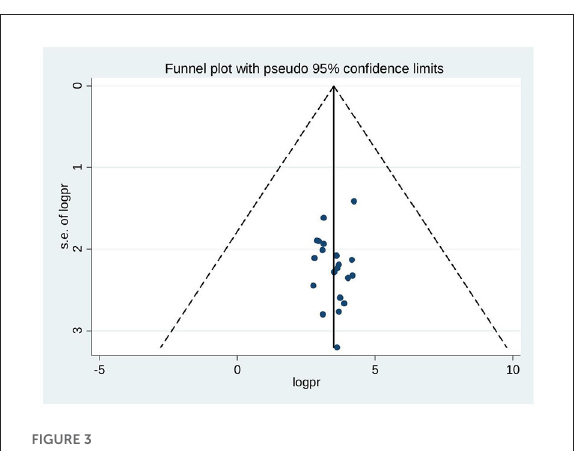
FIGURE3 Funnel plot showing symmetrical distribution of studies indicating absence of publication